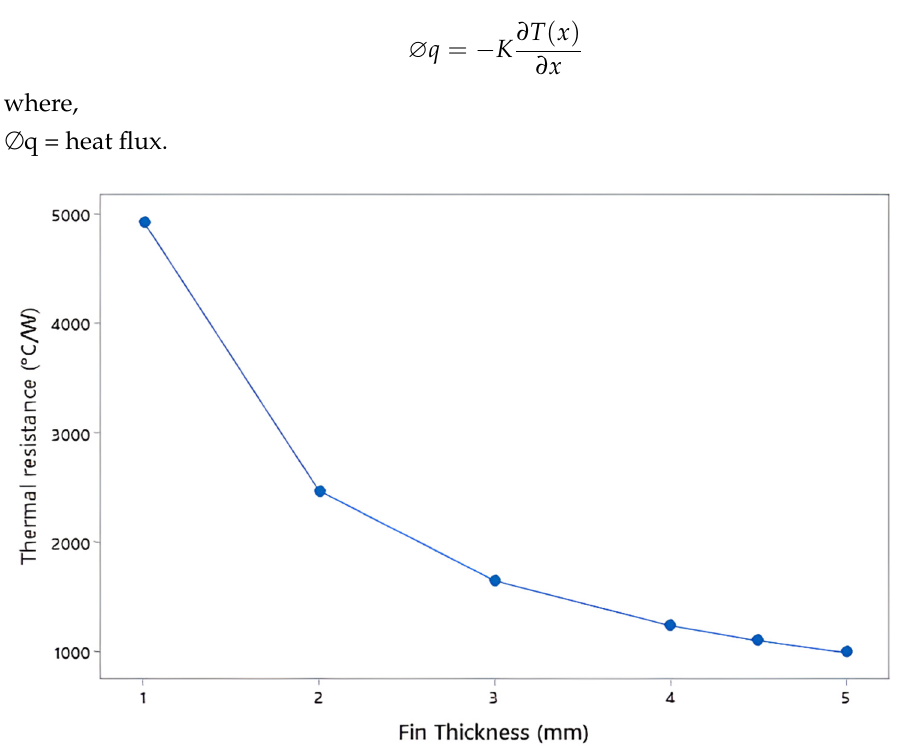
Figure 11. Thermal resistance for single fin vs. fin thickness (mm).